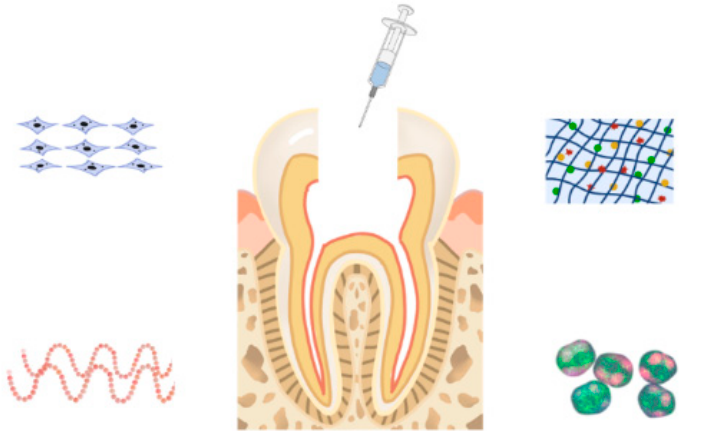
Figure 1. Application of hydrogel in pulp tissue